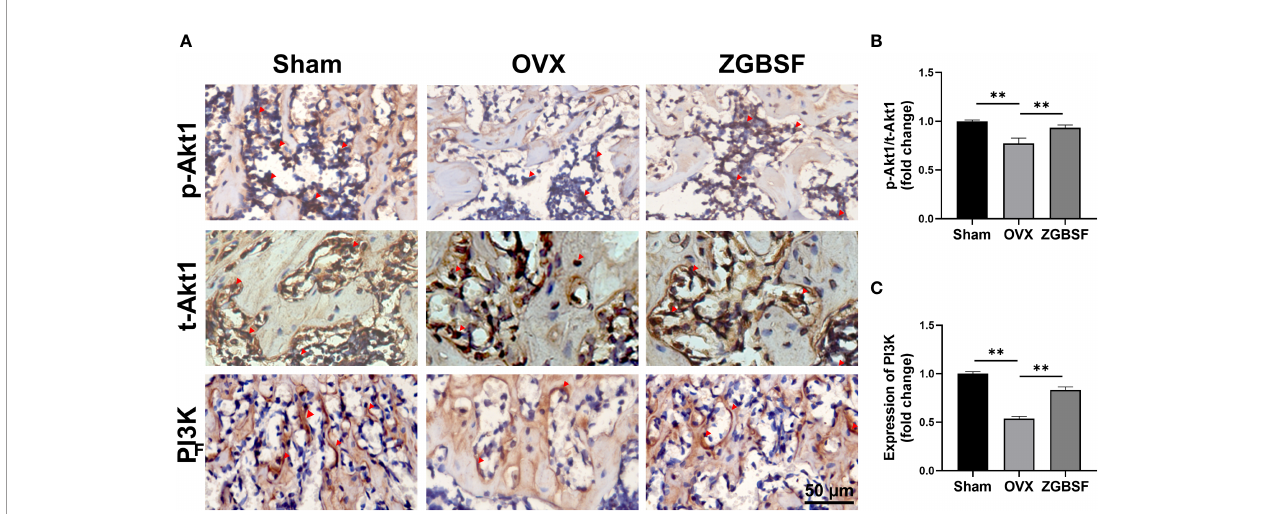
FIGURE 7 | ZGBSF activates the PI3K-Akt signaling pathway of femoral tissue. (A) Immunohistochemistry of t-Akt1, Akt1(S473), and PI3K of distal femur. (B, C) The quanti fi cation of Akt1(S473)/t-Akt1, and PI3K expression. Red arrows indicated the positive expression. Data were presented as mean ± SEM of three independent experiments. ** P <